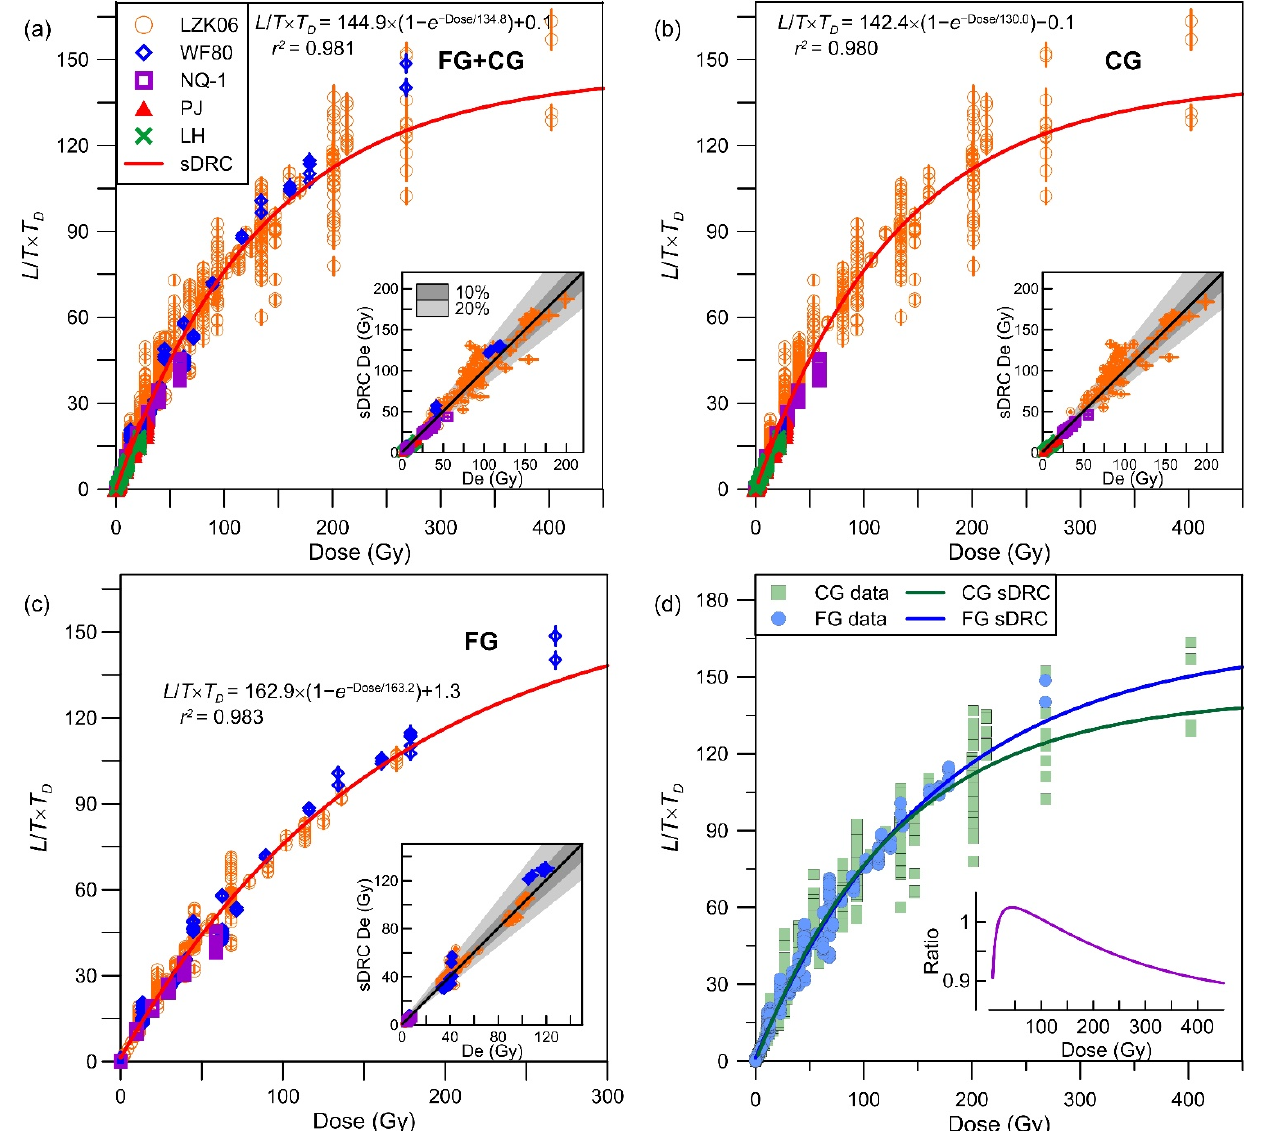
Figure 4. sDRC construction following the approach of Roberts and Duller (2004). ( a ) shows the sDRC constructed using all OSL data of all the FG and CG samples. ( b ) shows sDRC constructed using OSL data of the CG samples. ( c ) shows sDRC constructed using OSL data of the FG samples. The insets show the comparison between the sDRC- and individual DRC-determined D e values. The 1:1 line (solid line), 10 and 20% uncertainty (grey shadow area) are shown. ( d ) shows the sDRC comparison between FG and CG samples. Inset shows the L/T × T D ratio calculated using CG and FG sDRCs,